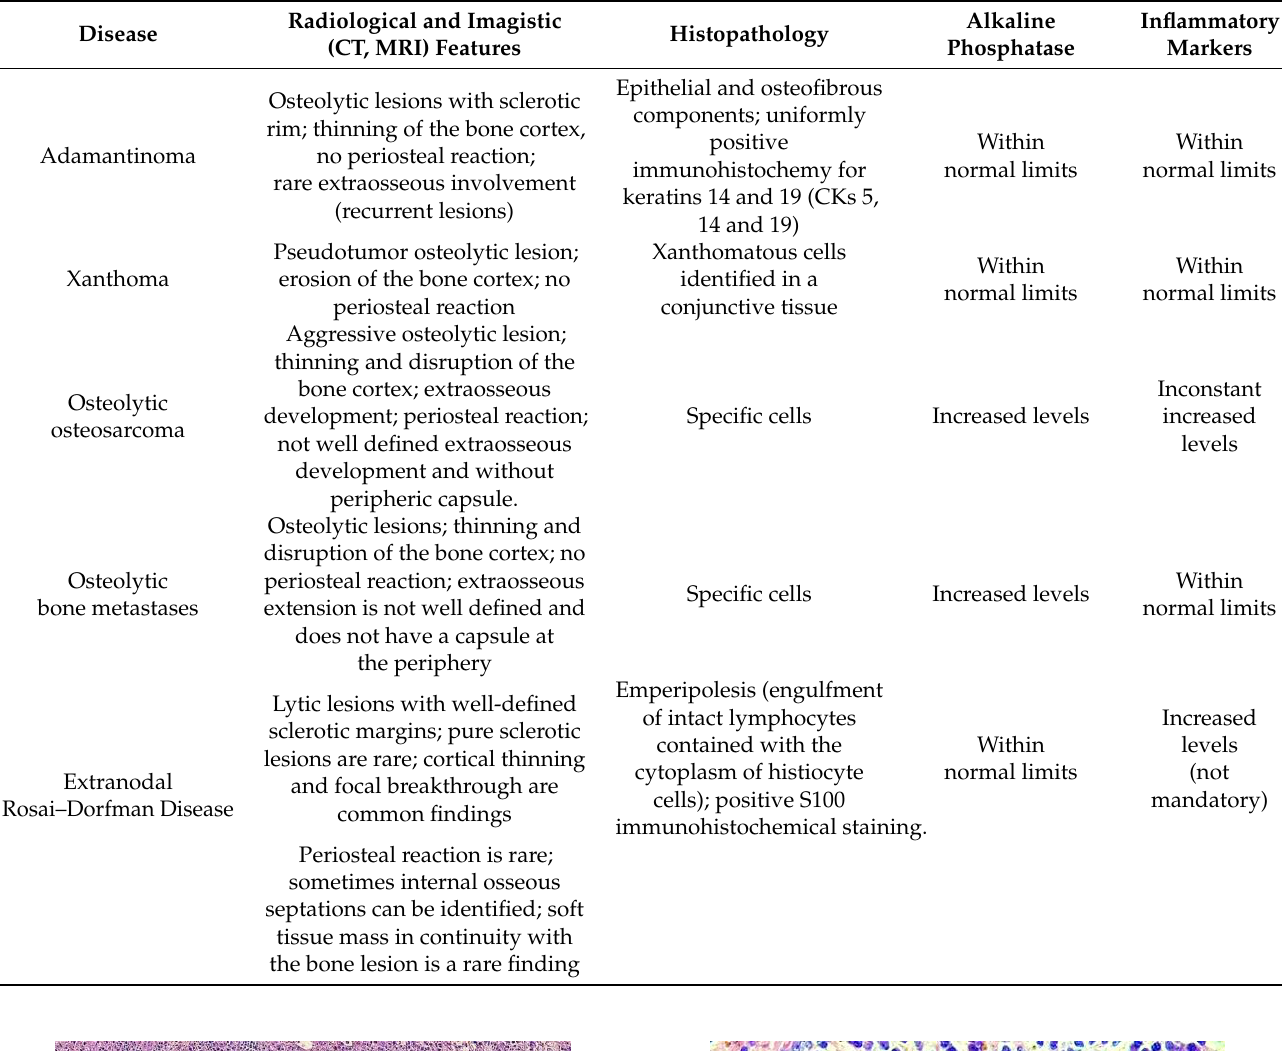
Table 1. Differential diagnosis features.